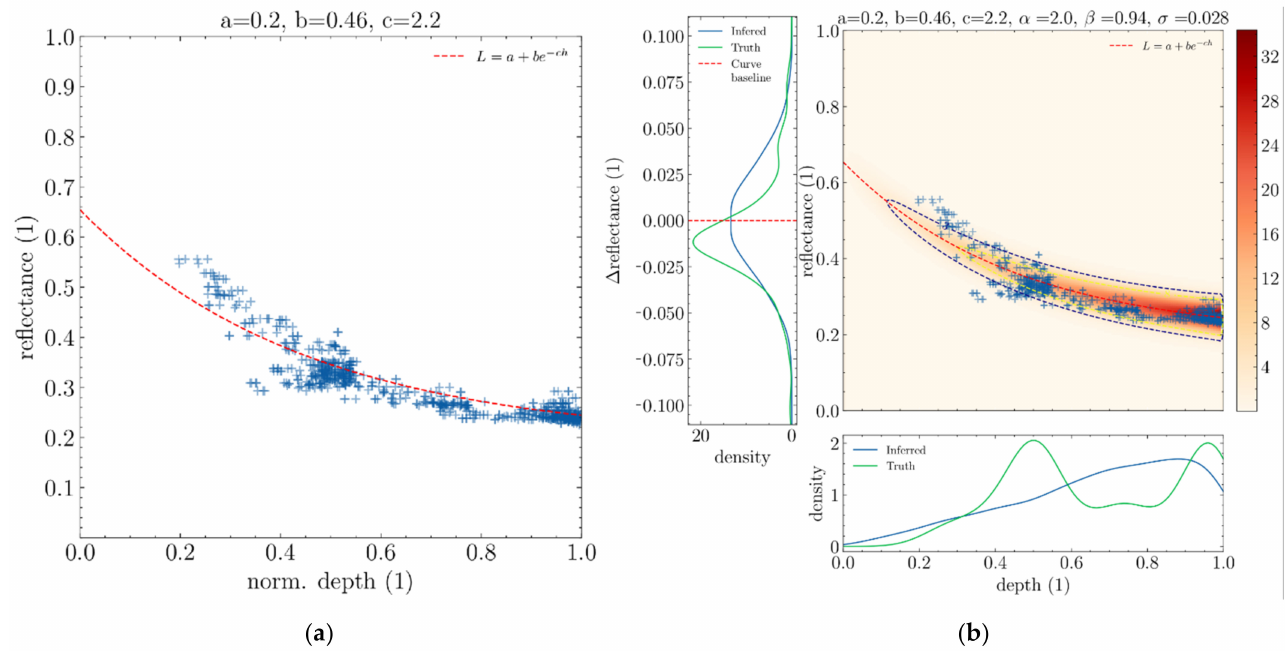
Figure 15. Regressing BNP parameters from the ground truth data displayed in Figure 13. ( a ) Re- gression of a cloud of points (blue crosses) to determine parameters a, b and c. ( b ) Using inferred parameters a, b and c to deduce statistical parameters σ , α and β